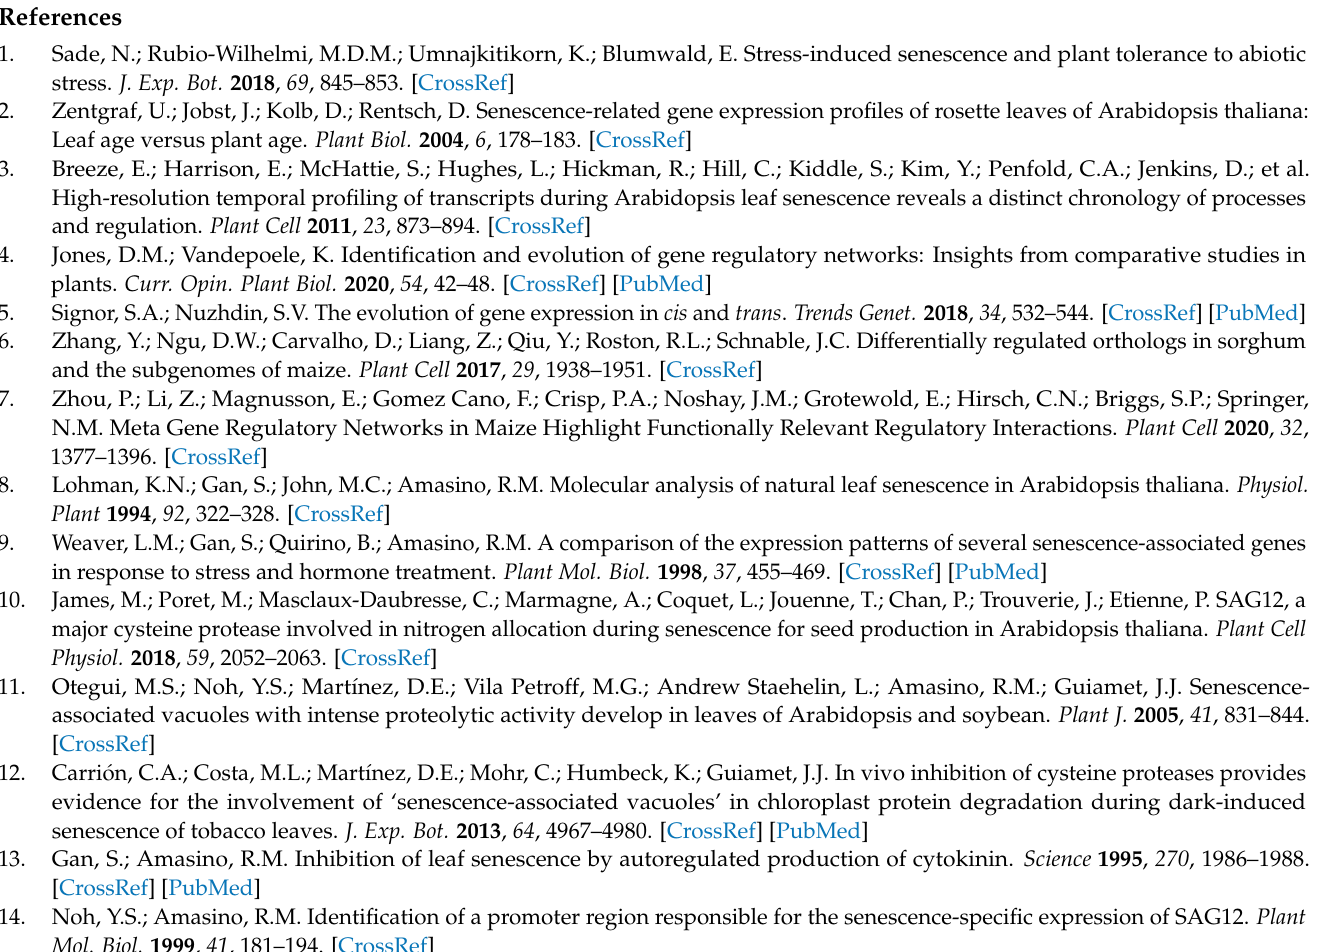
plant species. Table S5 : HOMER v4.11 analysis for over-represented regulatory motifs within the promoter regions of all AtSAG12